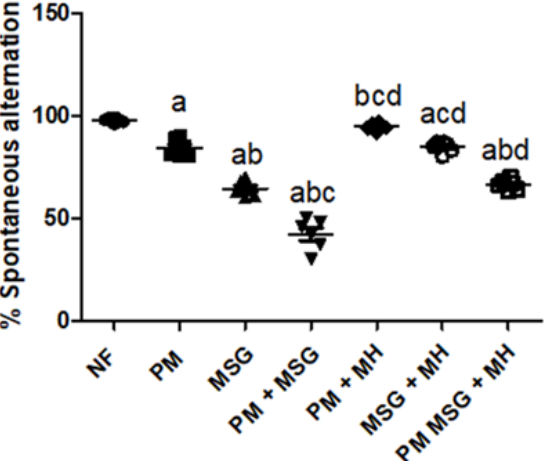
Figure 2. MH attenuates alterations in spatial working memory of PM and/or MSG—fed rat pups. Effect of 60 mg/kg Morin hydrate (MH) on low protein diet (PM) and/or 0.4 g/kg MSG on % spontaneous alteration in Y maze in rat pups. Data presented as mean ± SE ( n = 6). a–d: Significant from NF, PM, MSG, or PM + MSG, respectively. Statistical analysis was performed using one-way ANOVA, followed by Tukey’s post hoc test ( p < 0.05). [The data of the effect of MH on the control NF is not shown as it is not